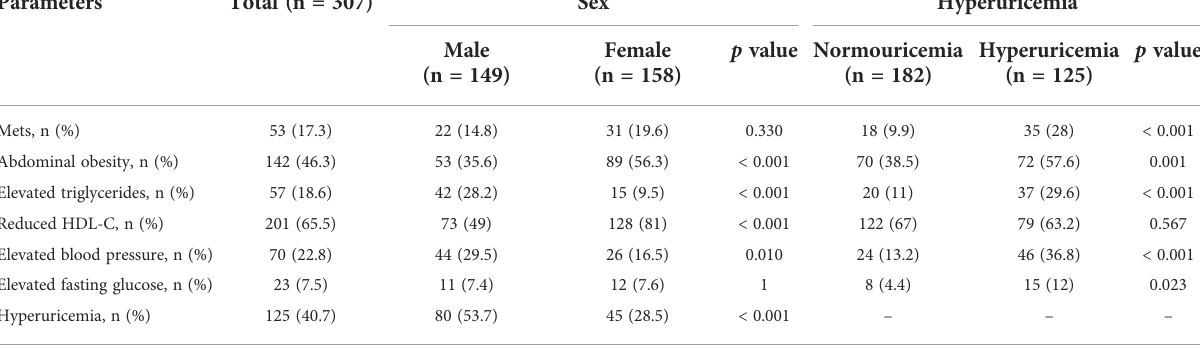
TABLE 2 Prevalence of MetS and its components in sex and hyperuricemia group.